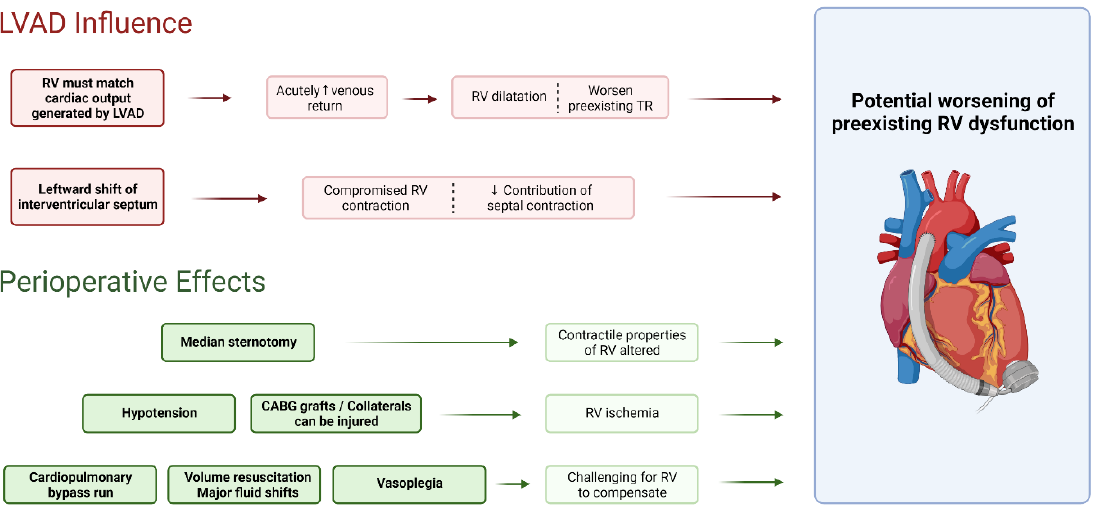
Figure 1. Influence of left ventricular assist device and perioperative factors on right heart function. CABG = coronary artery bypass graft; LVAD = left ventricular assist device; RV = right ventricle; TR = tricuspid regurgitation; ↑ = increased; ↓ = decreased. Created with BioRender.com, accessed on 22 April 2022.